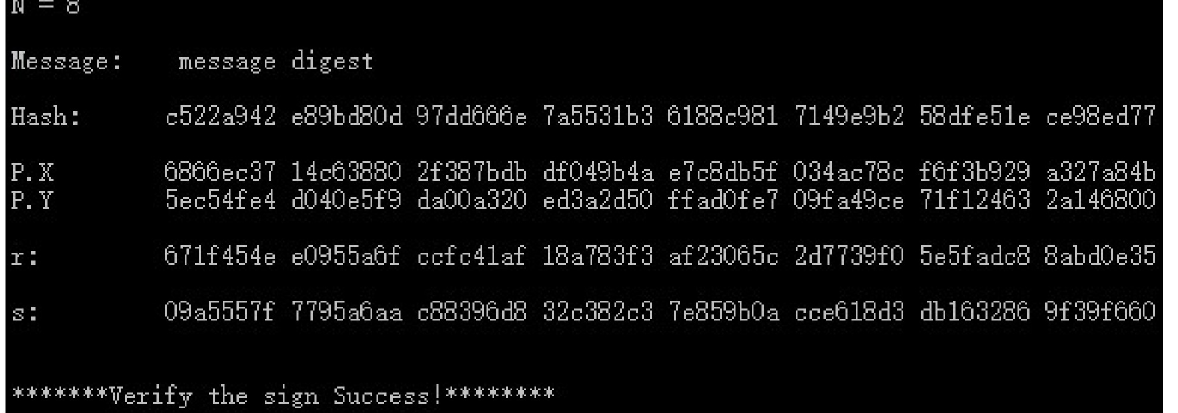
Fig 8. 8-party co-digital signature and verification